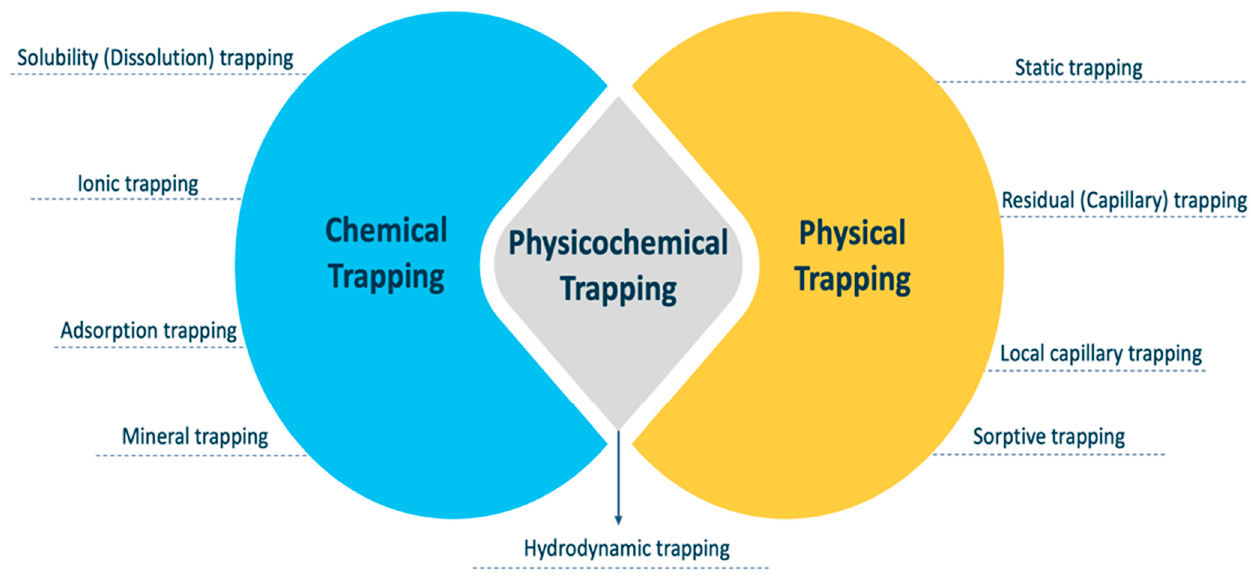
Figure 4. CO 2 -trapping mechanisms in geological formations.